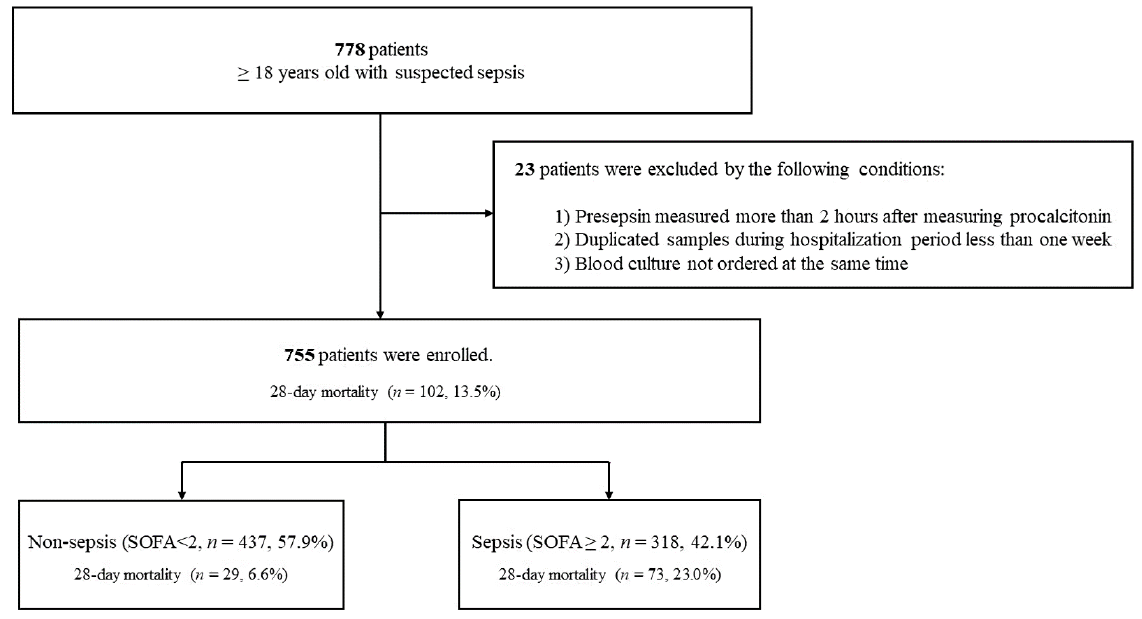
Figure 1. Study Figure 1. Study flowchart. Table 1. Baseline characteristics.